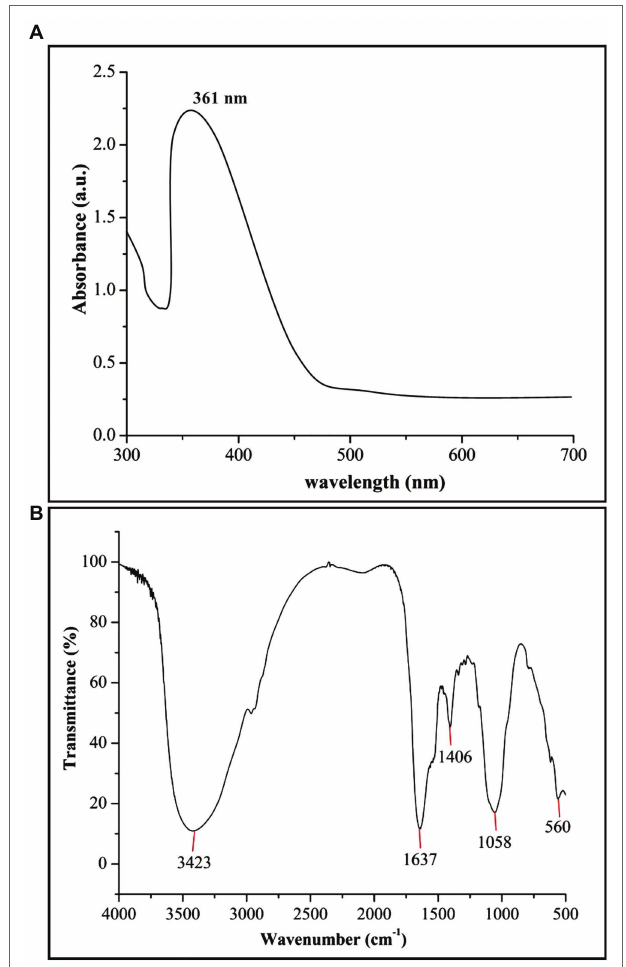
FIGURE 1 | Characterization of biogenic zinc oxide nanoparticles (ZnONPs) using (A) UV–vis spectroscopy and (B) Fourier transform infrared spectroscopy (FTIR)